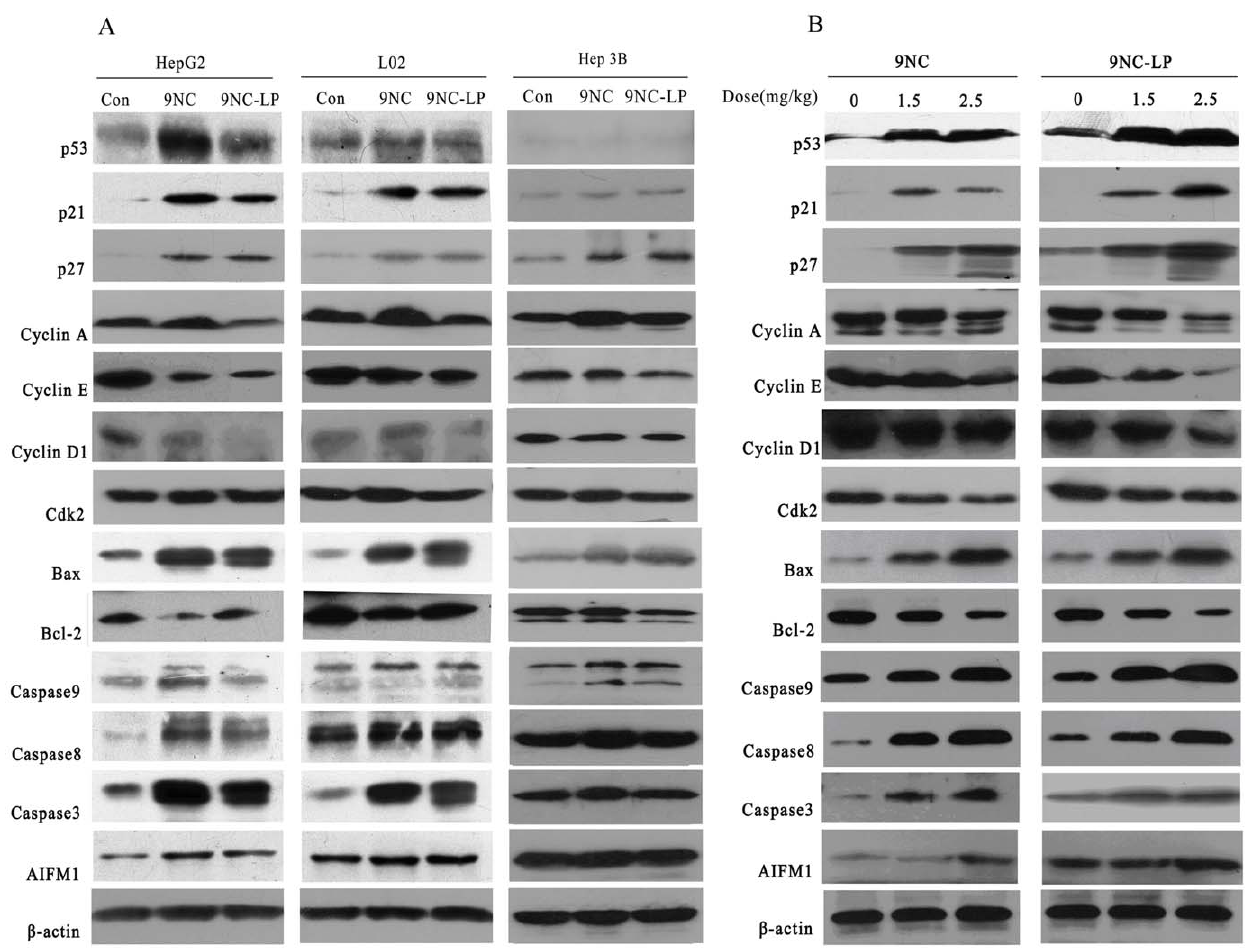
Figure 5. Effects of drugs on the expression of proteins related to cell cycle progression and apoptosis in human hepatocellular carcinoma cell line and normal liver cell line. In vitro , HepG2, L02 and Hep3B cells were exposed to the compound (1 m mol/L) for 24 h; then target proteins were examined by western blotting (A) . In vivo , compounds were given i.v. at doses of 1.5 mg/kg/d or 2.5 mg/kg/d on a 5/2/5 (5 days on, 2 days off and 5 days on) schedule for 3 weeks. The expression of proteins from tumor homogenates was analyzed by western blotting (B)